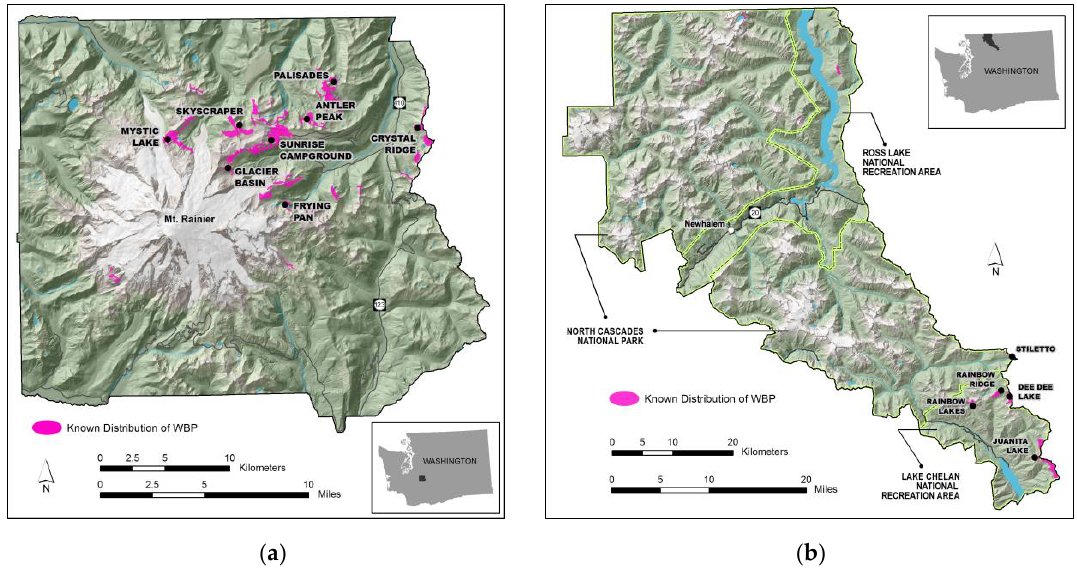
Figure 1. Study sites and whitebark pine distribution in ( a ) Mount Rainier National Park and ( b ) North Cascades National Park Service Complex. Study sites are labeled and indicated by black points.